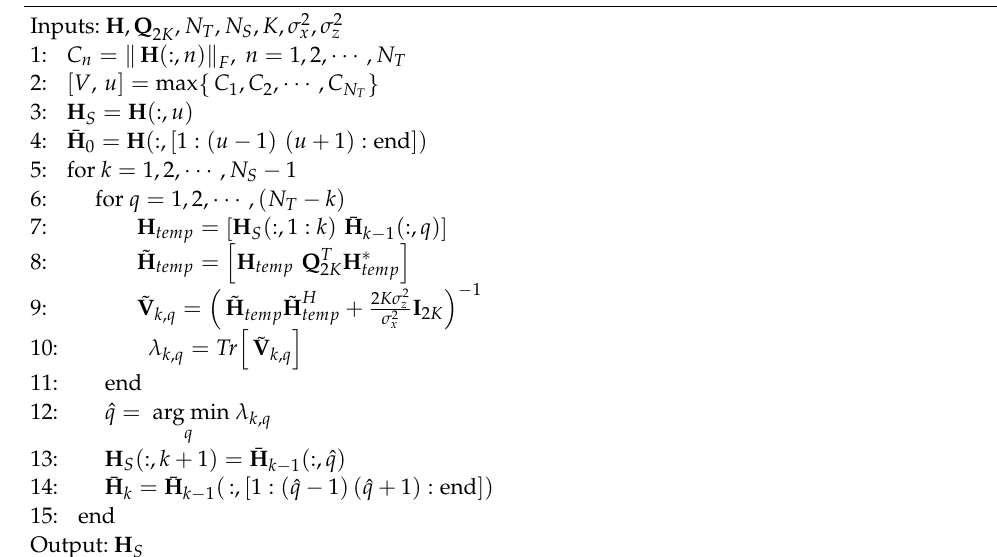
Algorithm 1 SINR-greedy-based TAS selection